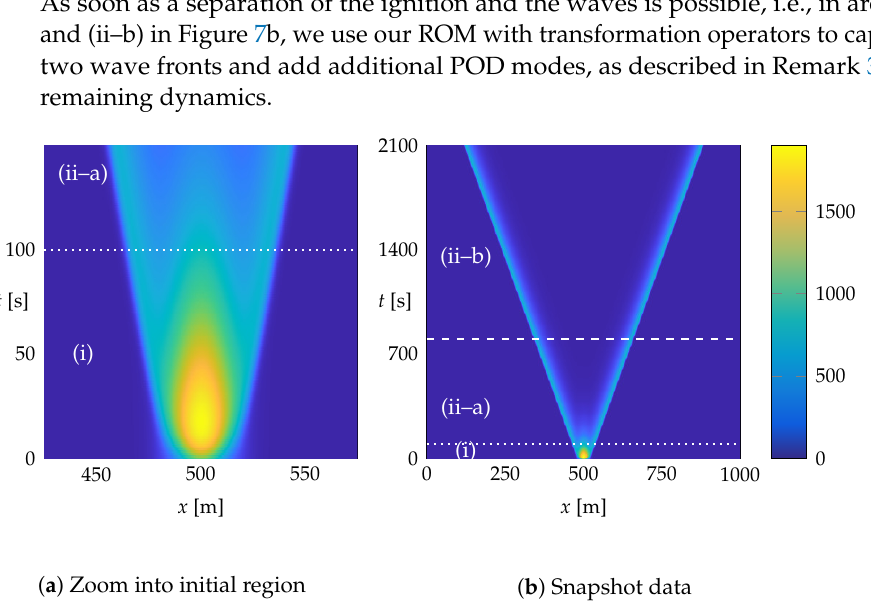
Figure 7. Evolution of the relative temperature for the wildland fire model with Gaussian initial condition